Question: Looking at the figure, what chart type is it?
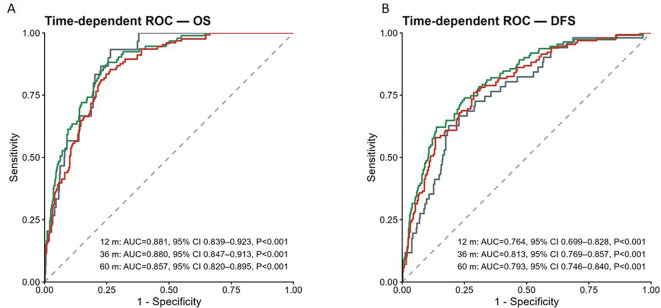
Answer: line